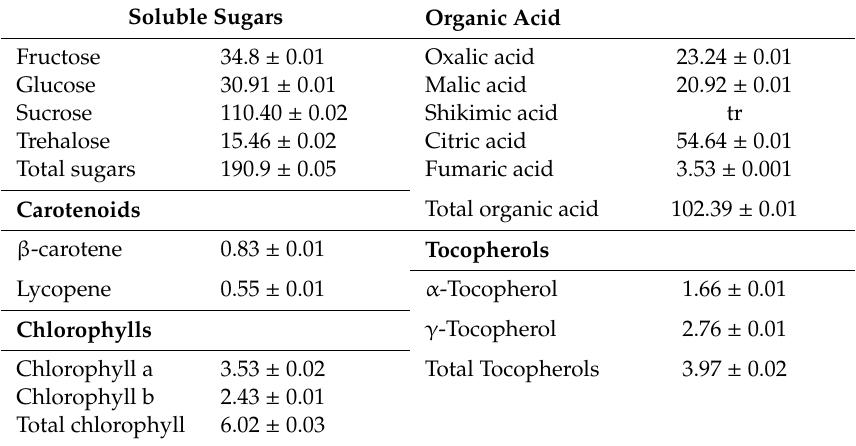
Table 2. Composition in sugars, organic acids (g 100 g − 1 fw), tocopherols, and pigments (mg 100 g − 1 fw) of the studied okra pods (mean ±